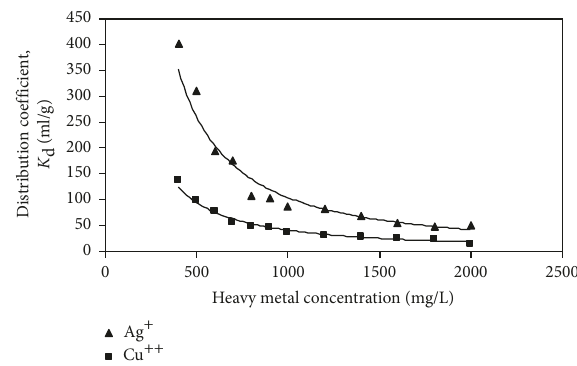
Figure 7: Distribution coefficient of Ag + and Cu ++ on Saudi clay as a function of initial